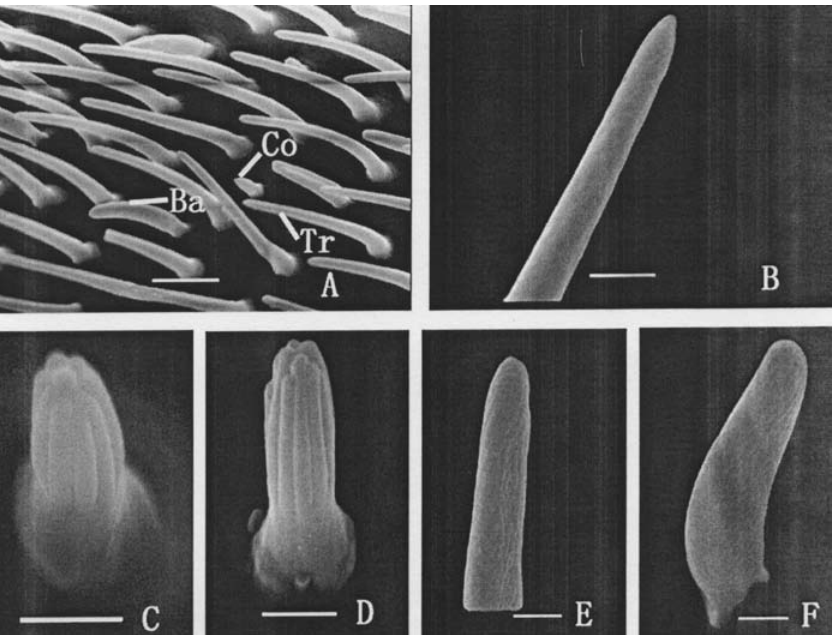
Fig.4. SEM micrographs of antennal sensilla of female decapitating phorid fly P. tricuspis (A) antennal sensilla on flagellum: (Ba) sensilla basiconica, (Co) sensilla coeloconica, and (Tr) sensilla trichodea; (B) sensilla trichodea; (C and D) sensilla coeloconica; (E and F) sensilla basiconica. Scale bars: (A) 5μm; (B, C, D, E, and F)